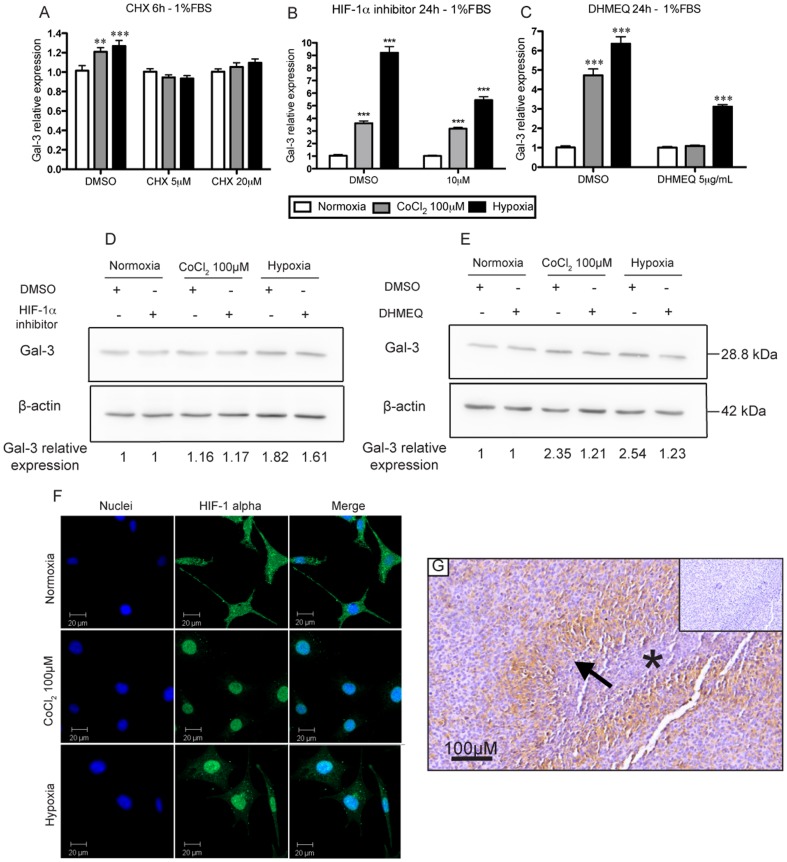
Gal-3 upregulation in hypoxia depends on HIF-1α and NF-κB and is blocked by cicloheximide.
A. qRT-PCR analysis of NG97ht cells treated with cycloheximide (CHX) 5 µM and 20 µM and its control (DMSO) and in cells exposed to either normoxia, CoCl2 or hypoxia in serum-deprived medium for 6 h demonstrated significant increase in gal-3 expression in cells exposed to CoCl2 and hypoxia compared to normoxia in the group treated with DMSO, but not when cells were exposed to CHX. B. The exposure to HIF-1α inhibitor 10 µm (CAS 934593-90-5) demonstrated gal-3 decreased induction by qRT-PCR in cells exposed to hypoxia, but not normoxia and CoCl2. DMSO used as control. C. The exposure to DHMEQ 5 µg/mL, an NF-κB inhibitor, decreased gal-3 induction by qRT-PCR both in CoCl2 and hypoxia compared to normoxia after 24 h in serum-deprived medium. DMSO used as control. D. Western blot analysis with the HIF-1αinhibitor demonstrated a slight decrease in gal-3 only in cells exposed to hypoxia, but not normoxia and CoCl2, compared to DMSO control (experiment performed once). E. Western blot analysis also demonstrated decreased gal-3 induction in cells treated with DHMEQ compared to DMSO in hypoxia and CoCl2 compared to normoxia after 24 h in serum-deprived medium. F. Cells in normoxia display scattered HIF-1α (green) throughout cytoplasm, while cells exposed to CoCl2 and hypoxia display HIF-1α mainly in cells nuclei (blue). G. In vivo, NF-κB demonstrates to be upregulated in pseudopalisading areas, which display increased gal-3 expression. Representative experiments performed at least in three independent assays and data are presented as mean±SEM. **p<0,01; ***p<0.001.